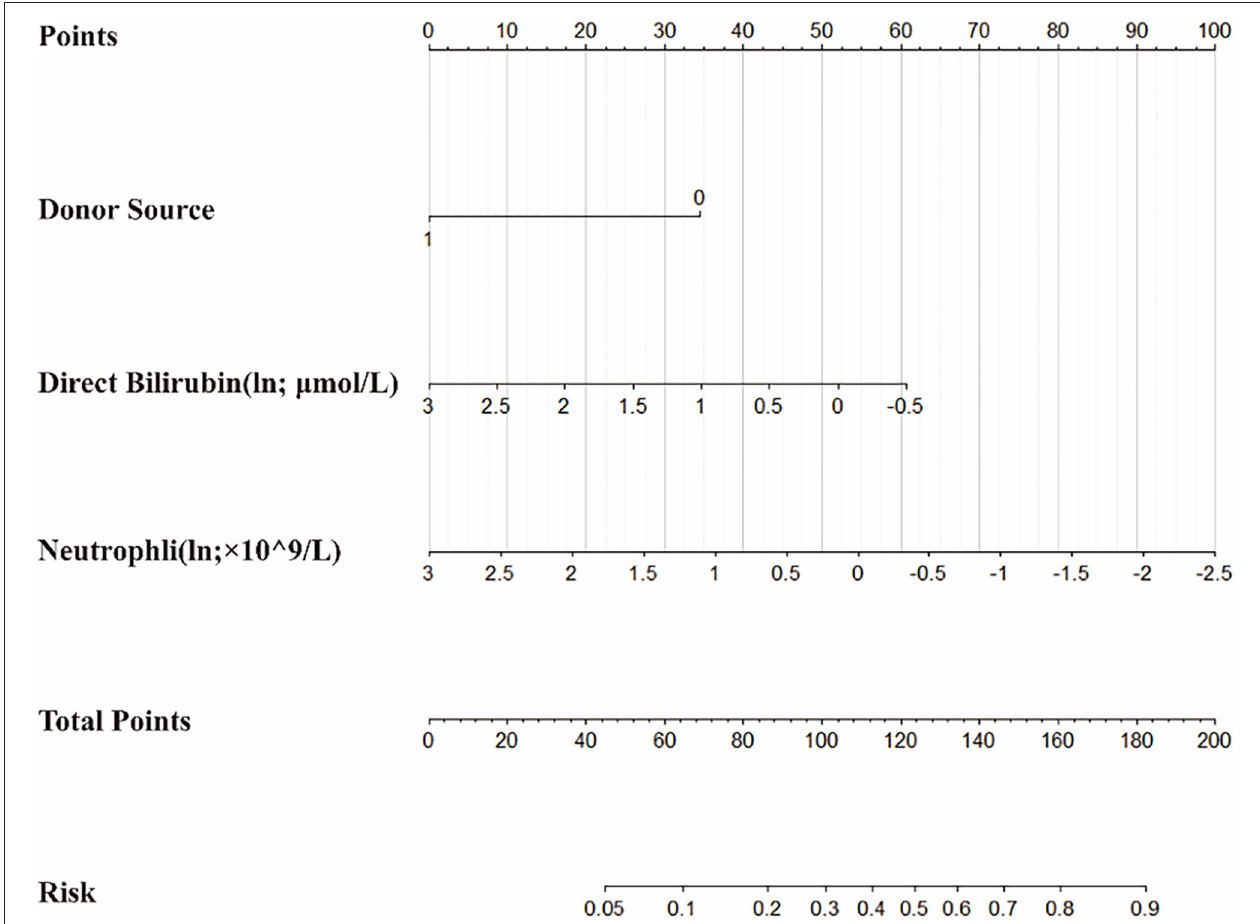
FIGURE 5 | The nomogram to estimate the risk of BKV activation in renal transplant recipients (RTRs). Based on the nomogram, the position of each variable on the corresponding axis can match a point to the points axis. The sum points of all the variables can draw a line from the total points axis to the risk axis and obtain the